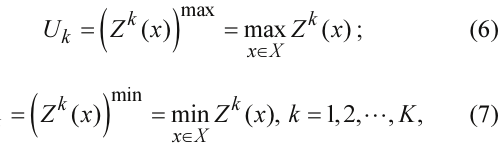
Table 1. Linguistic expression of triangular fuzzy scale